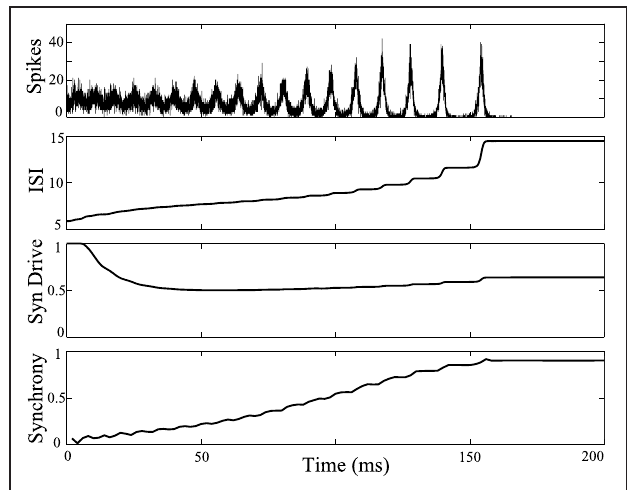
FIGURE 2 | Tonic-clonic transition in model network. Synchrony emerges in large scale networks with synaptic depression and ramped current from I = 0nA to I = − 5nA and inclusion of synaptic depression. Average synaptic strength across the population is plotted against time in the 3rd panel labeled as “Syn Drive.” Synchrony as a function of time is plotted at the bottom, measured using the Kuramoto order parameter. Synchrony emerges as interspike intervals of the neurons exceed about 7ms. Synchrony will not occur if tonic current is held at 5nA keeping interspike intervals shorter than about 7ms.